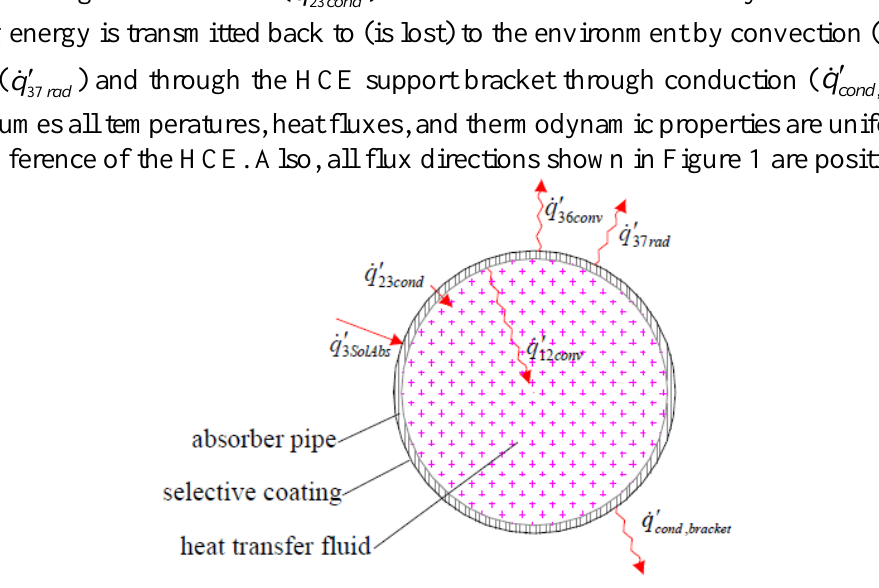
Figure 1. One-dimensional steady-state energy balance and for a cross-section of an